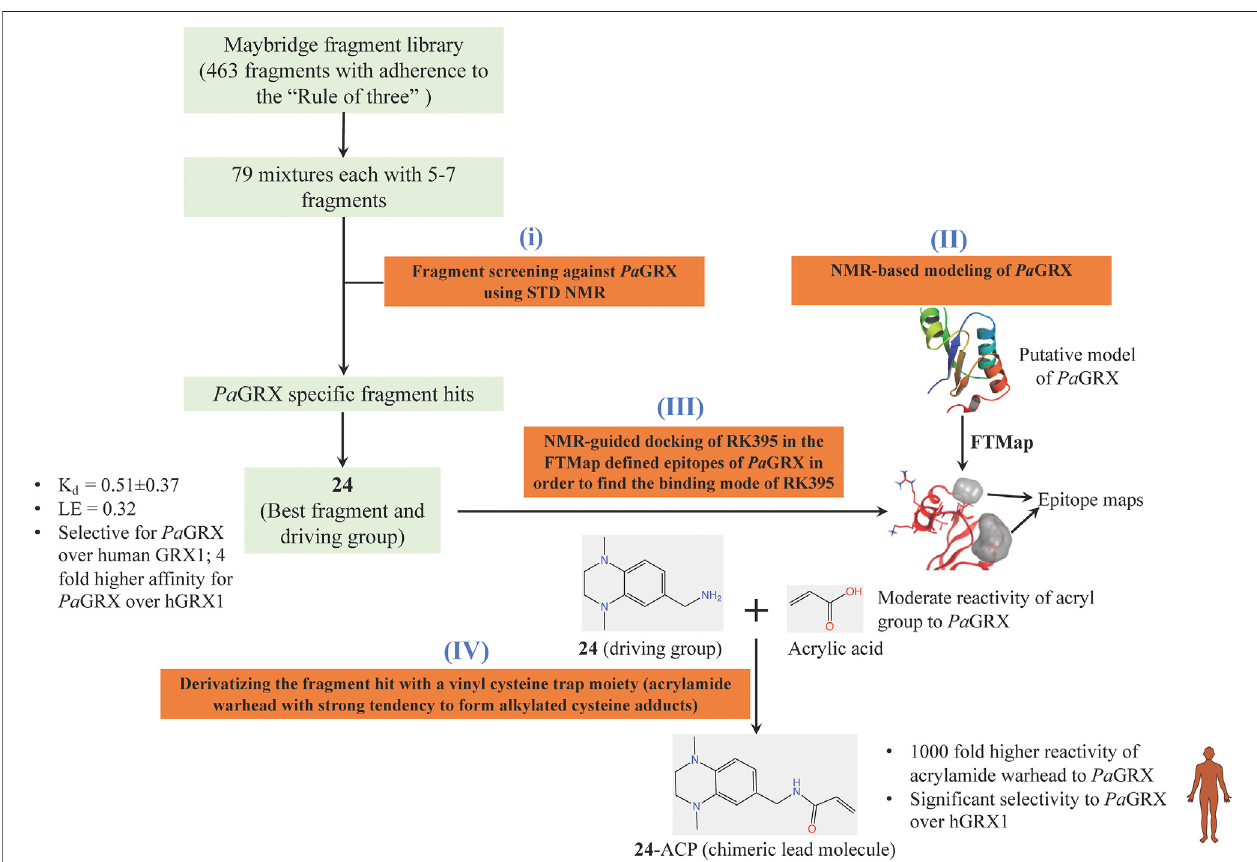
FIGURE 6 | FBDD campaign using NMR against Pa GRX to identify best driving group, derivatization. A vinyl cysteine trap moiety resulted in the development of chimeric lead molecule with enhanced reactivity and selectivity to Pa GRX over human GRX1 (hGRX1). Putative model Pa GRX and FTMap identi fi ed epitope maps of Pa GRX in this fi gure are adopted from (Khattri et al., 2020) with permission from the authors.